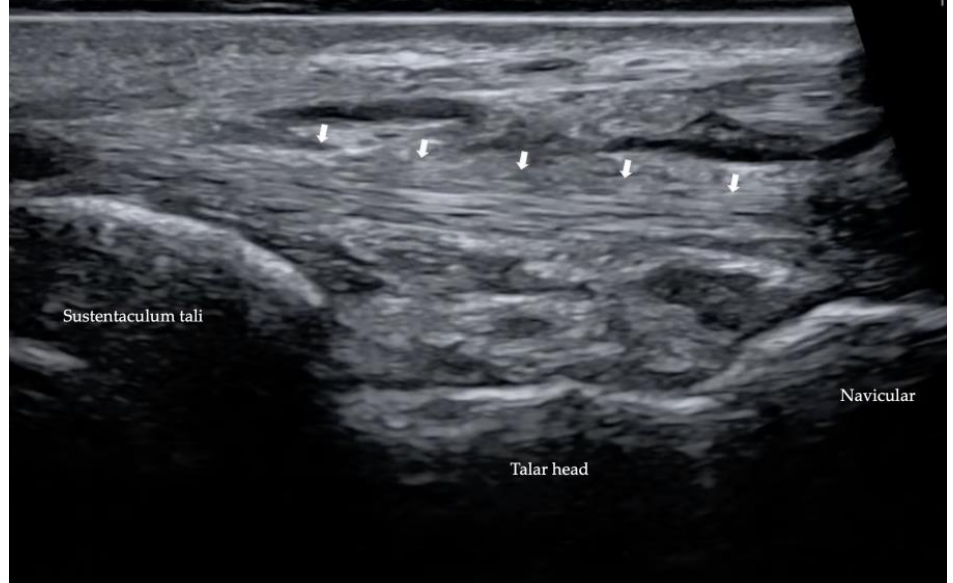
Figure 11. Ultrasonography of spring ligament (marked by white arrows).